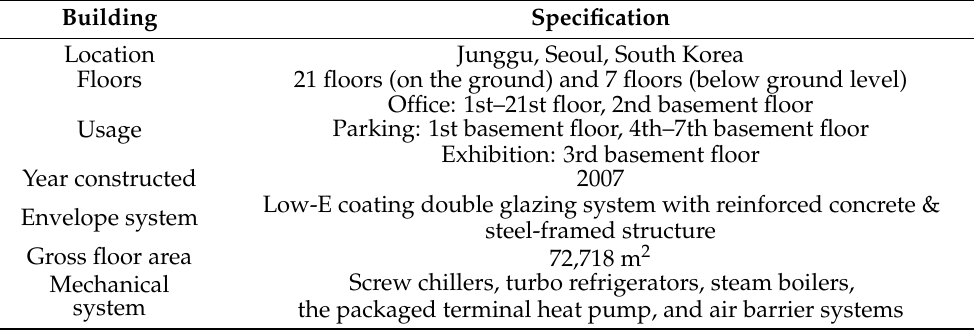
Figure 3. A cross-section and a plan of the 10th floor.